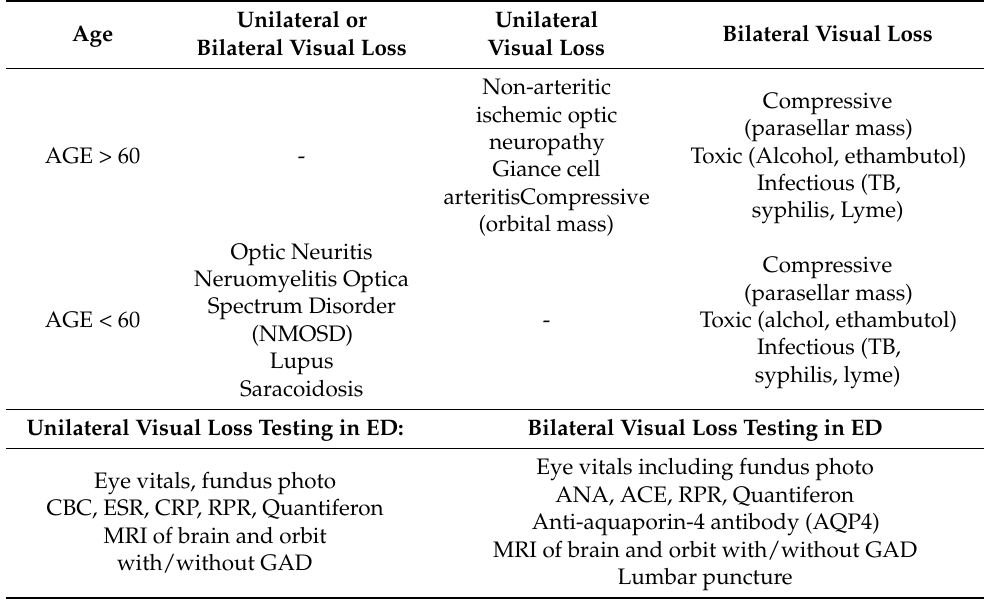
Table 5. Differential of optic neuropathies categorized by age and appropriate testing and work up in the ED setting [28–30].